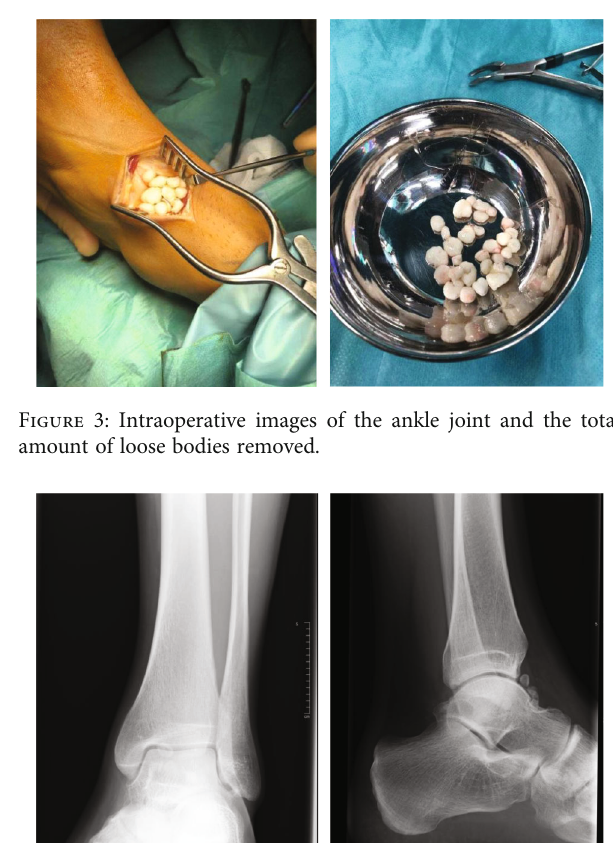
Figure 2: MRI demonstrating coronal, axial, and sagittal views of the ankle.